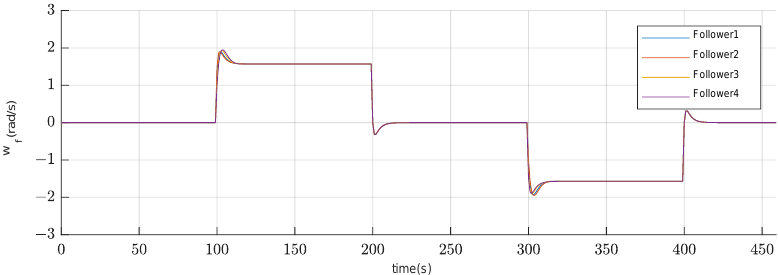
Figure 18. The variation curve of ω l for the leader during the movement.